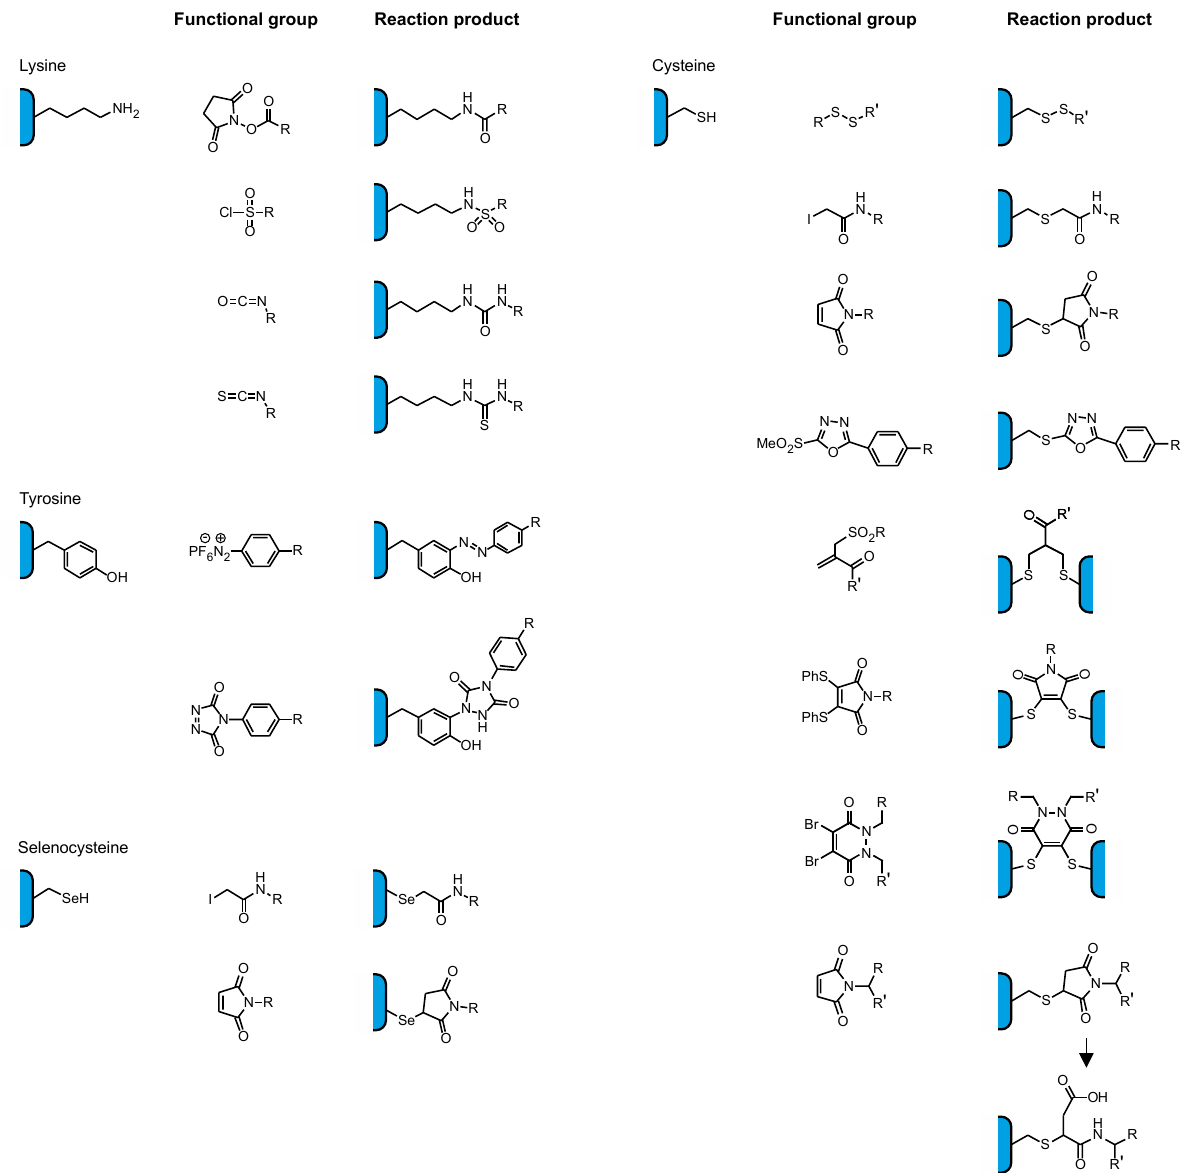
Figure 2. Overview of functional groups and their reaction products with the corresponding amino acid